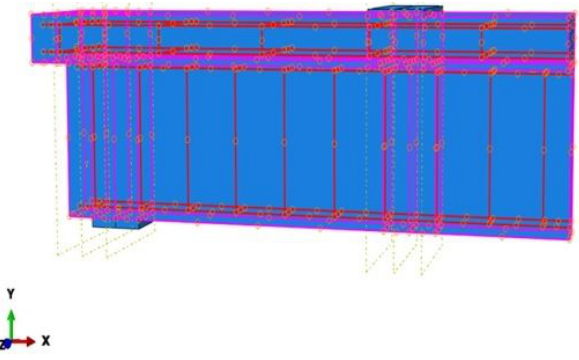
Figure 15: The truss used to represent the steel